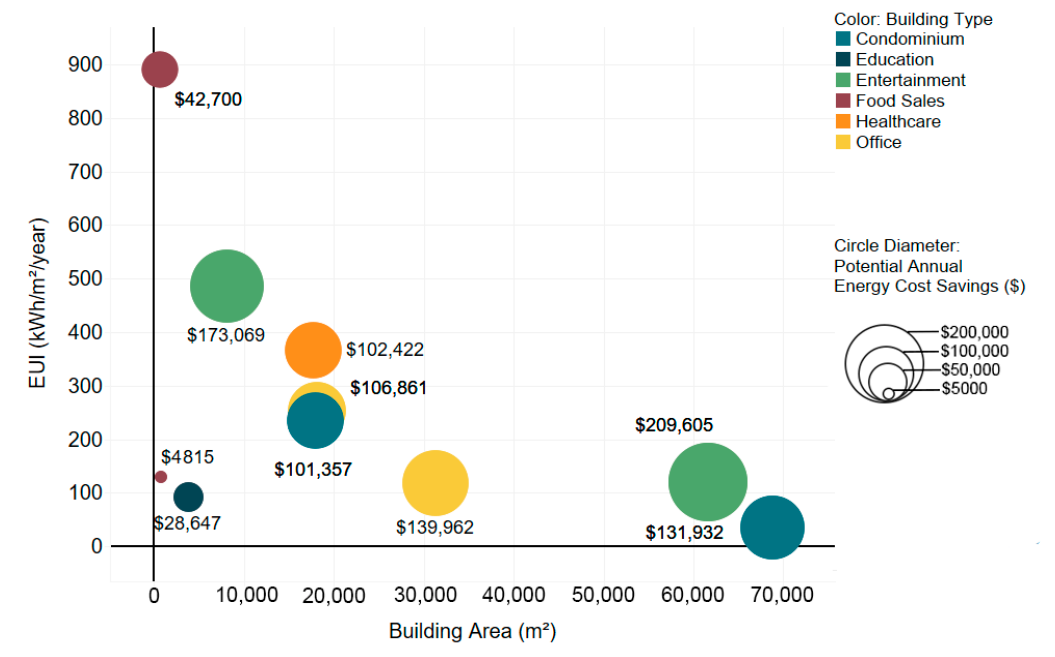
Figure 3. Energy use intensity (EUI; kWh/m 2 /year) of each building vs. building area (m 2 ) with estimated potential annual energy cost savings indicated by size of bubble, and building type indicated by color.